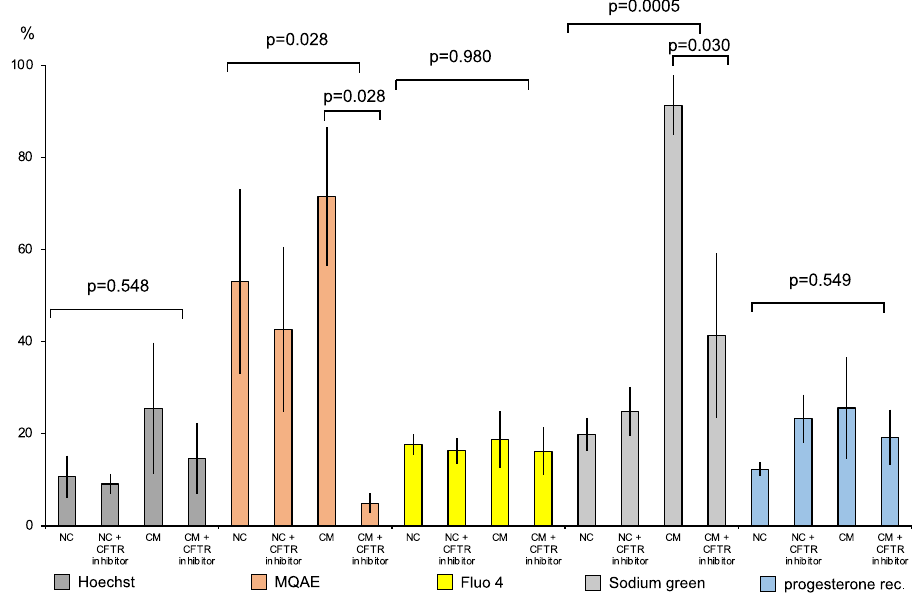
Figure 3. Results of FC sorting of 10,000 or more spermatozoa of five fertile donors after incubation in either capacitating (CM) or non-capacitating (NC) culture medium and in the presence or absence of the CFTR-ion channel inhibitor CFTRinh-172 (24